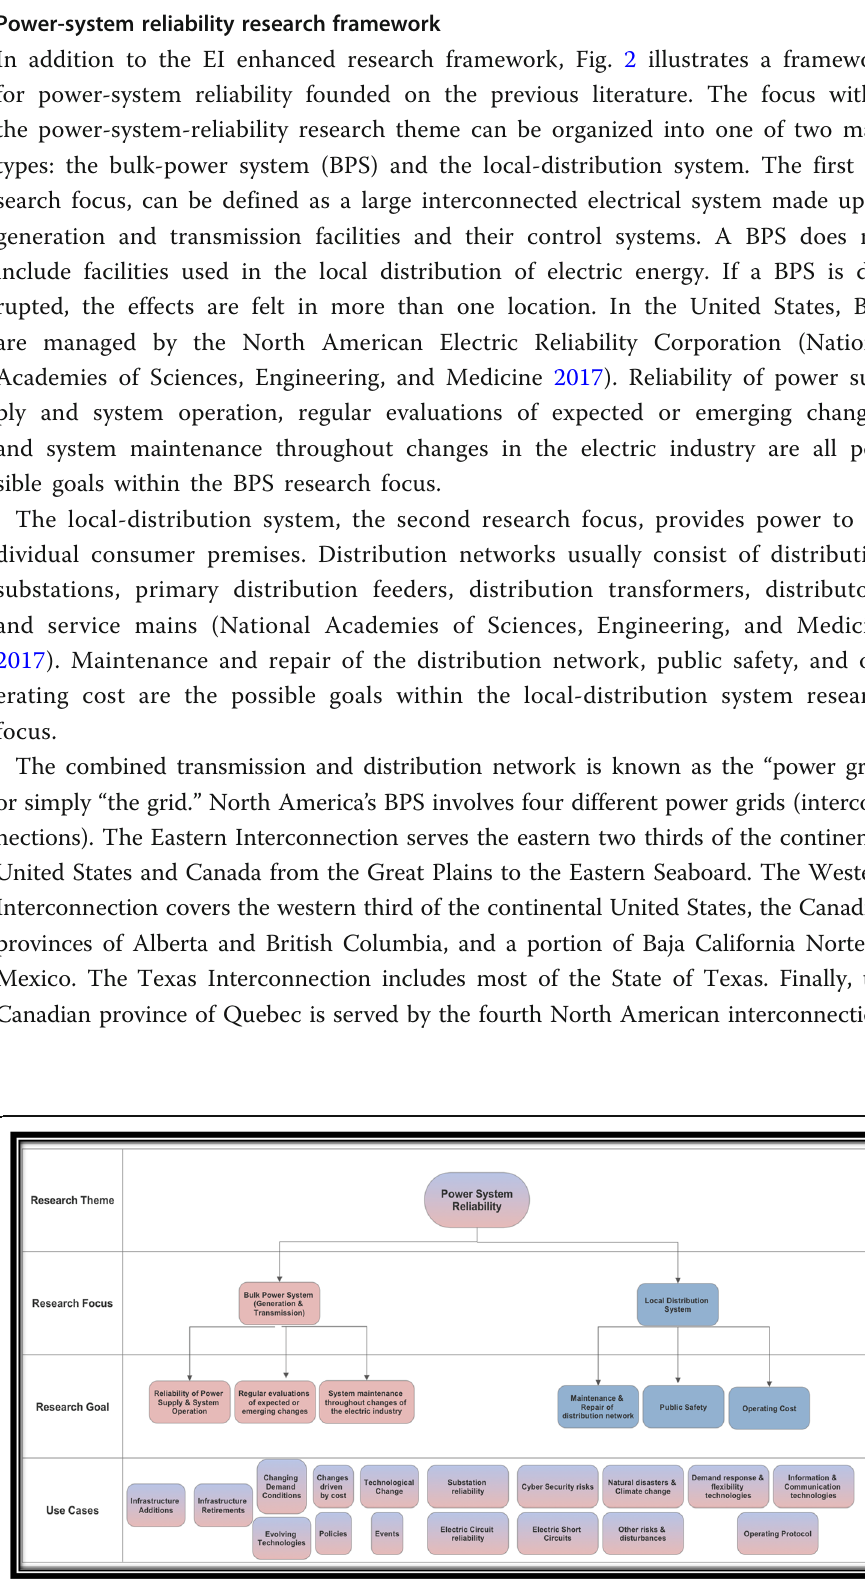
Fig. 2 Power-system reliability research